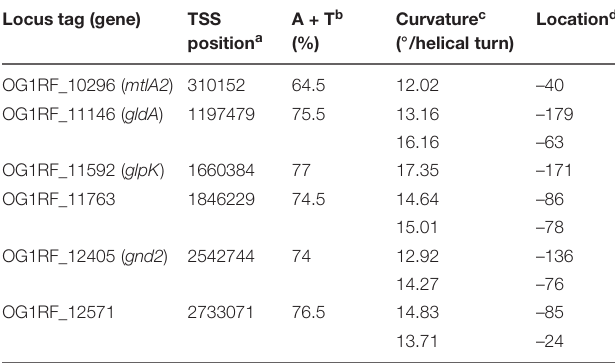
TABLE 4 | Potential intrinsic curvatures within promoter